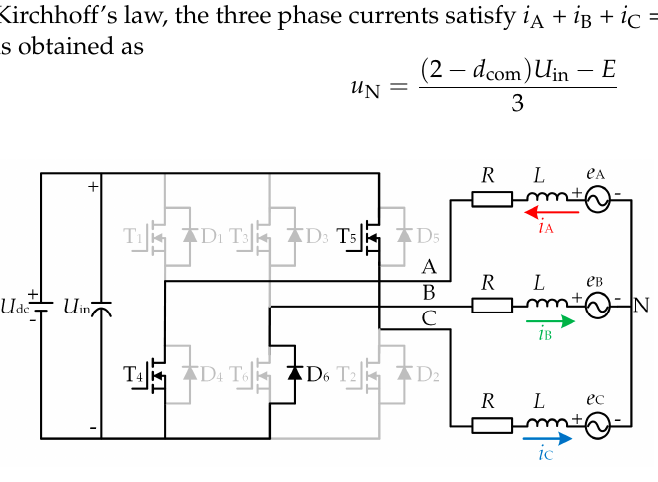
Figure 4. The circuit in the commutation from B + A − to C + A −